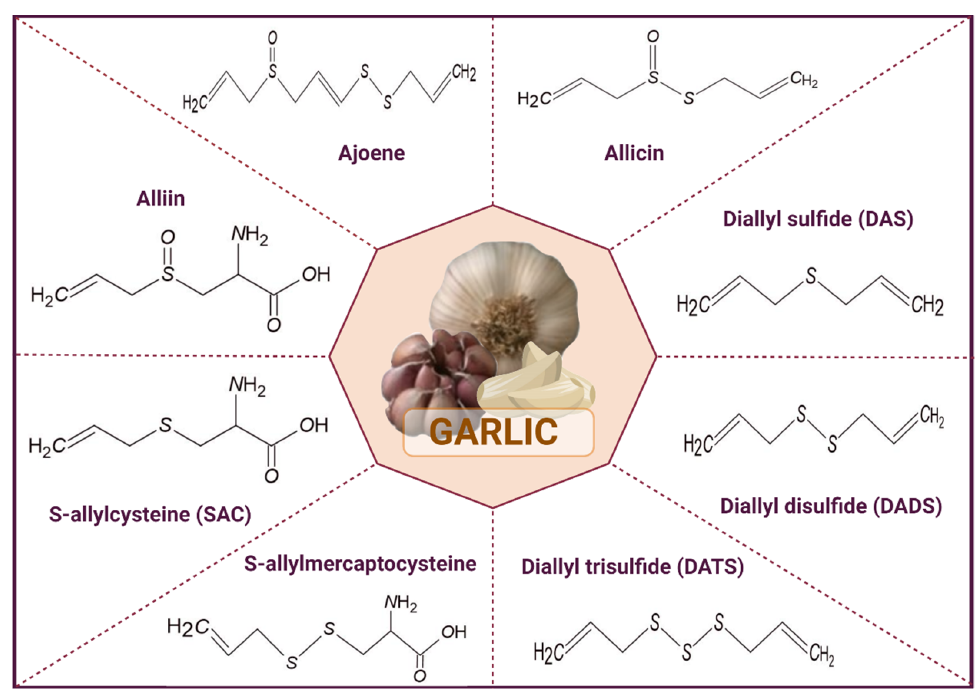
Figure 1. Structures of some of the organosulfur compounds present in garlic.